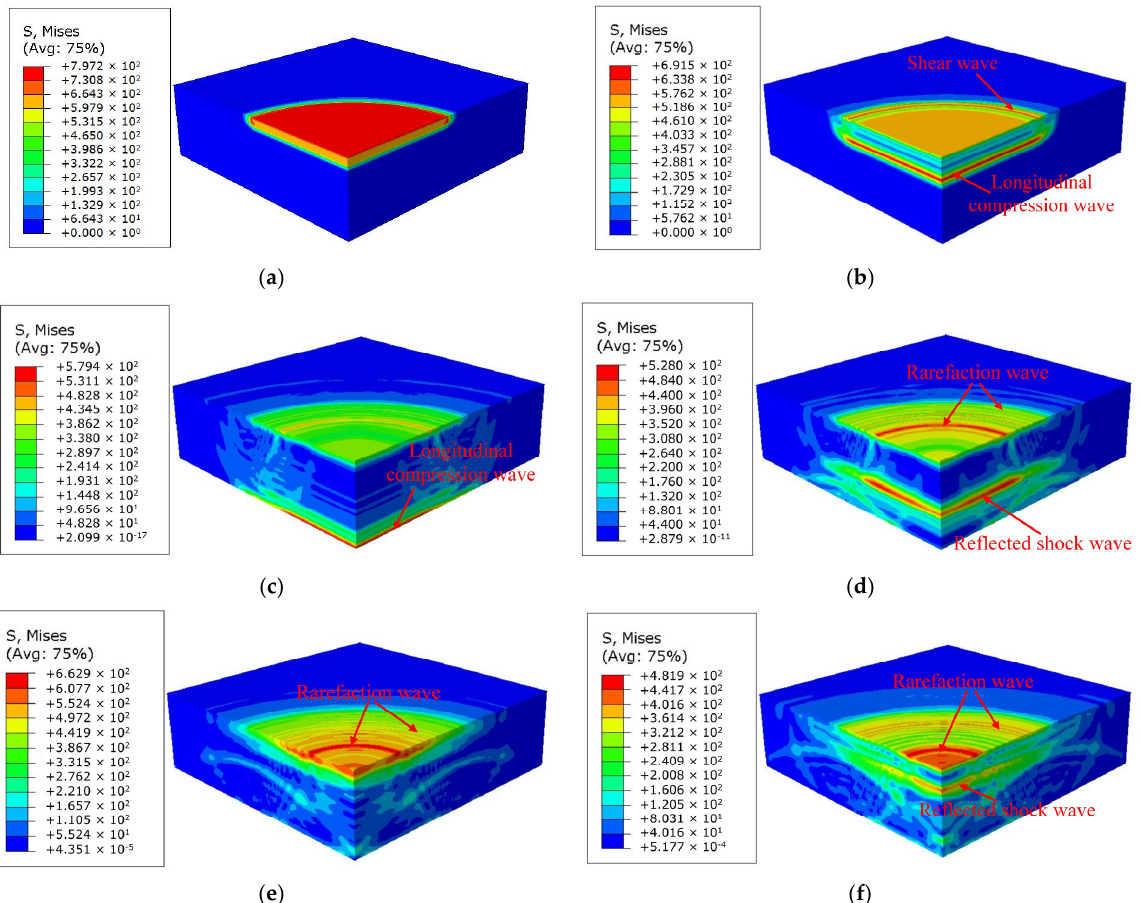
Figure 10. Stress wave nephograms of laser shock wave propagating in samples at different times of ( a ) 30 ns, ( b ) 70 ns, ( c ) 280 ns, ( d ) 370 ns, ( e ) 560 ns, and ( f ) 600 ns.